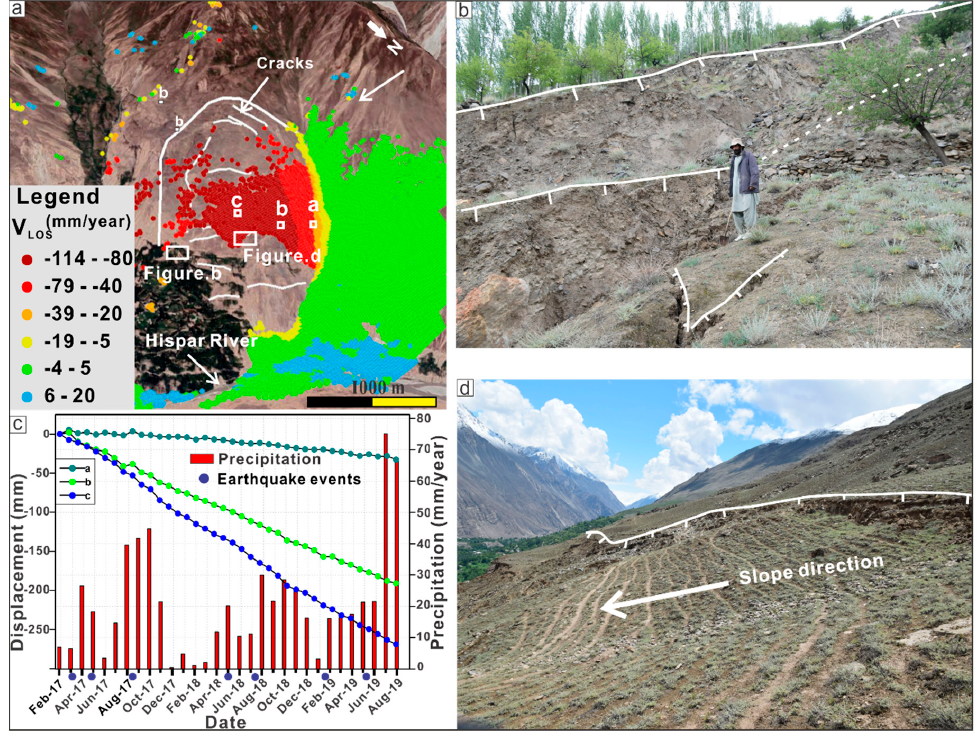
Figure 10 . Humarri Landslide. (a) Slope deformation rates in the direction of LOS as determined from Figure 10. Humarri Landslide. ( a ) Slope deformation rates in the direction of LOS as determined from InSAR at Humarri Slope. (b and d) Examples of tension cracks in the landslide. (c) Displacement time InSAR at Humarri Slope. ( b , d ) Examples of tension cracks in the landslide. ( c ) Displacement time series for representative pixels, for point a, b, and c. series for representative pixels, for point a, b, and